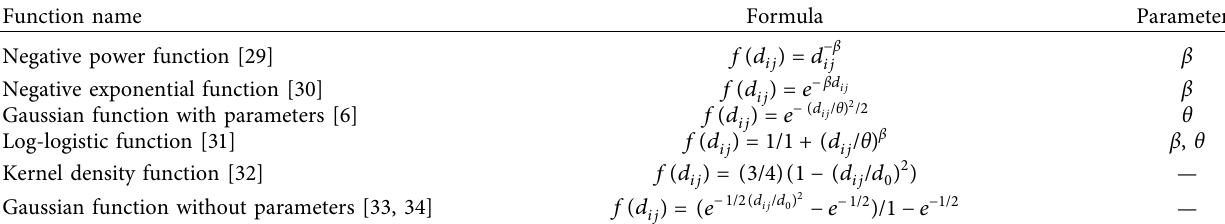
Table 3: Distance decay